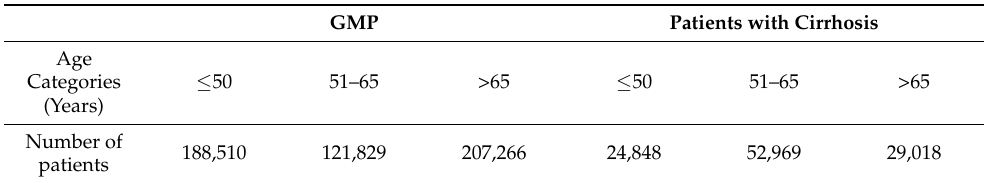
Table 1. Demographic characteristics for hospitalized general medicine and patients with cirrhosis, grouped by